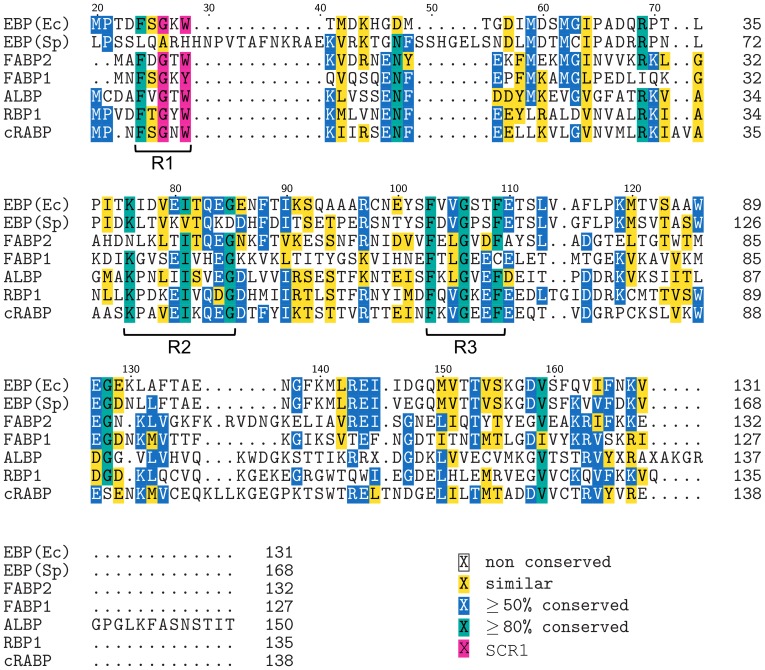
Multiple sequence alignment of EBP(Ec) and EBP(Sp) with members of the FABP family.A multiple sequence alignment of EBP(Ec) and EBP(Sp) with five members of the FABP family was performed using MUSCLE. The five FABP sequences used in the alignment were; intestinal-FABP-2 (FABP2), liver-FABP-1 (FABP1), adipocyte lipid-binding protein (ALBP) from Rattus norvegicus, retinol-binding protein-1 (RBP1) and cellular retinoic acid-binding protein (cRABP) from Homo sapiens. Positions where ≥50% of residues are similar are shaded yellow. Positions where residue identity is ≥80% are shaded blue. Positions with ≥80% residue identity are shaded green. SCR1 (≥80% identity) is shaded magenta and the three regions of clustered ≥80% amino acid identity are labelled R1, R2 and R3. Amino acid position numbering is with respect to EBP(Sp), for which the first 20 amino acids are not shown.